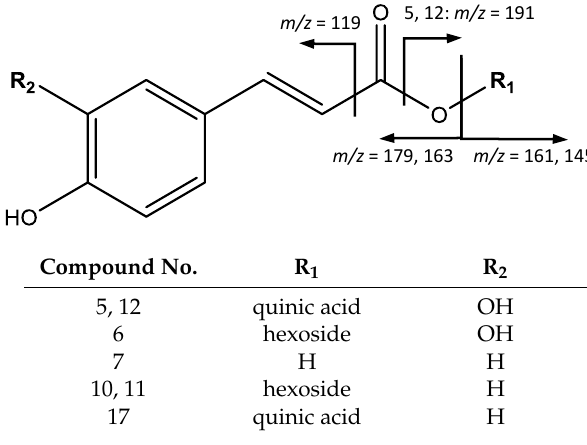
Figure 8. p -coumaric acid derivatives structure and main